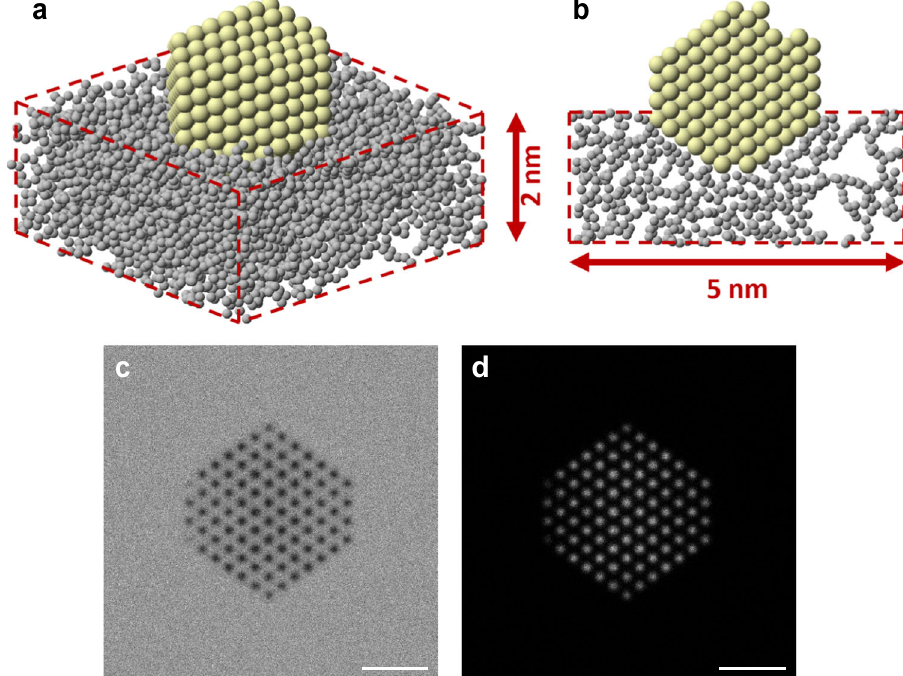
Fig. 1 Simulated Pt nanoparticle partially embedded in an amorphous carbon support. a 3D model and b cross-section, c simulated ABF STEM image, and d simulated ADF STEM image at 10 4 e − Å − 2 . The scale bars in c – d are 1